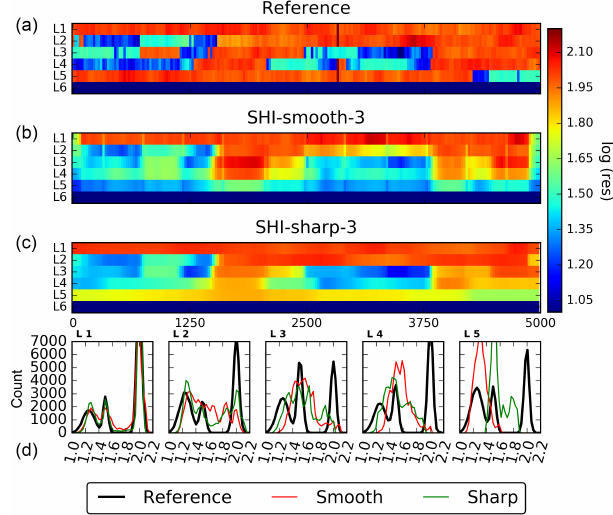
Figure 4. The figure shows an east–west cross section of resistiv- ity for the reference system (realization number 20), and inversion results for smooth and sharp inversion, respectively. The last row shows a histogram of resistivity for each layer. The black curve is the resistivity distribution for the reference system, the red curve shows the resistivity distribution for the smooth inversion, and fi- nally the green curve shows the resistivity distribution for the sharp